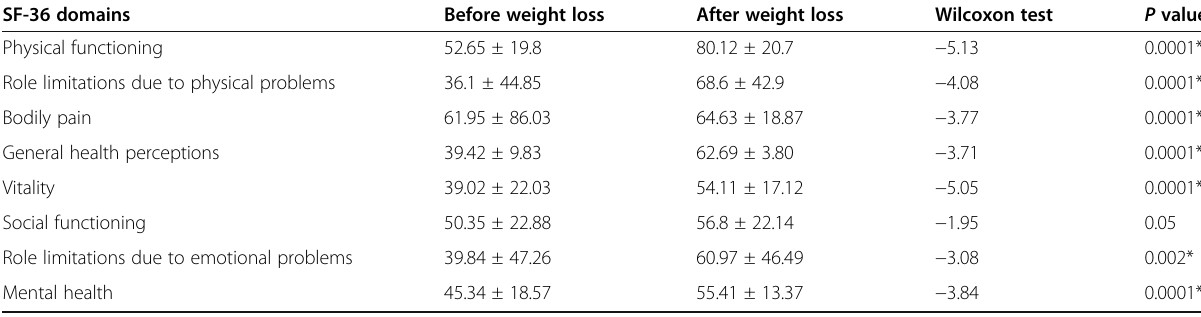
Table 2 Comparison between SF-36 quality of life scores before and after weight loss SF-36